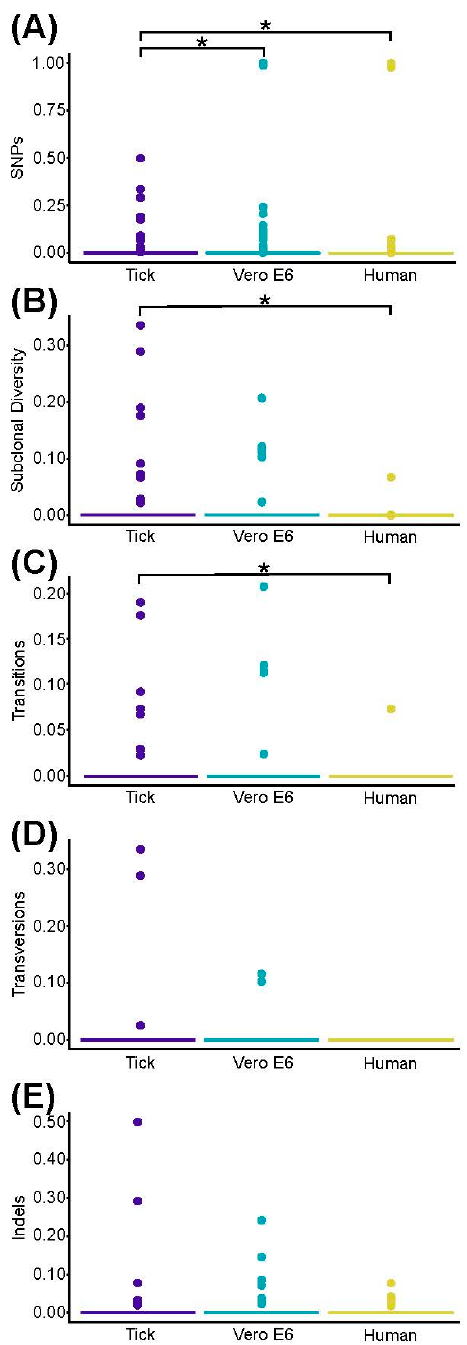
Figure 5. Viral diversity analysis of the SFTSV populations from AMFC 17-1 (human), USAMRIID-HLP23 (tick pool), and USAMRIID-HLP23_VE6 (Vero E6) isolates. For each sample, the three genomic segments (L, M, and S) were concatenated and the frequencies of each parameter for every nucleotide position with at least 100 reads populated. For every parameter and each sample, median frequencies were calculated along the entire genome. Error bars (representing the inter-quartile range) are not visible due to the γ -axis scale, determined by the presence of outliers. Outliers are represented by colored dots. ( A ) Frequency of SNPs (nucleotide positions presenting with a base change that is supported by at least 2% of the reads and by no more than 50% of those). ( B ) Subclonal diversity (SCD: events—SNPs and indels—per site per genome). ( C , D , E ) Individual frequencies (events per site per genome) of transitions, transversions, and indels (insertions and / or deletions), respectively. An asterisk indicates that di ff erences were significant ( p < 0.05) using the Wilcoxon rank sum test (Table S2).